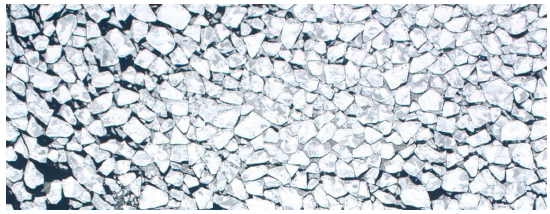
Figure 7: Aerial image of the marginal ice